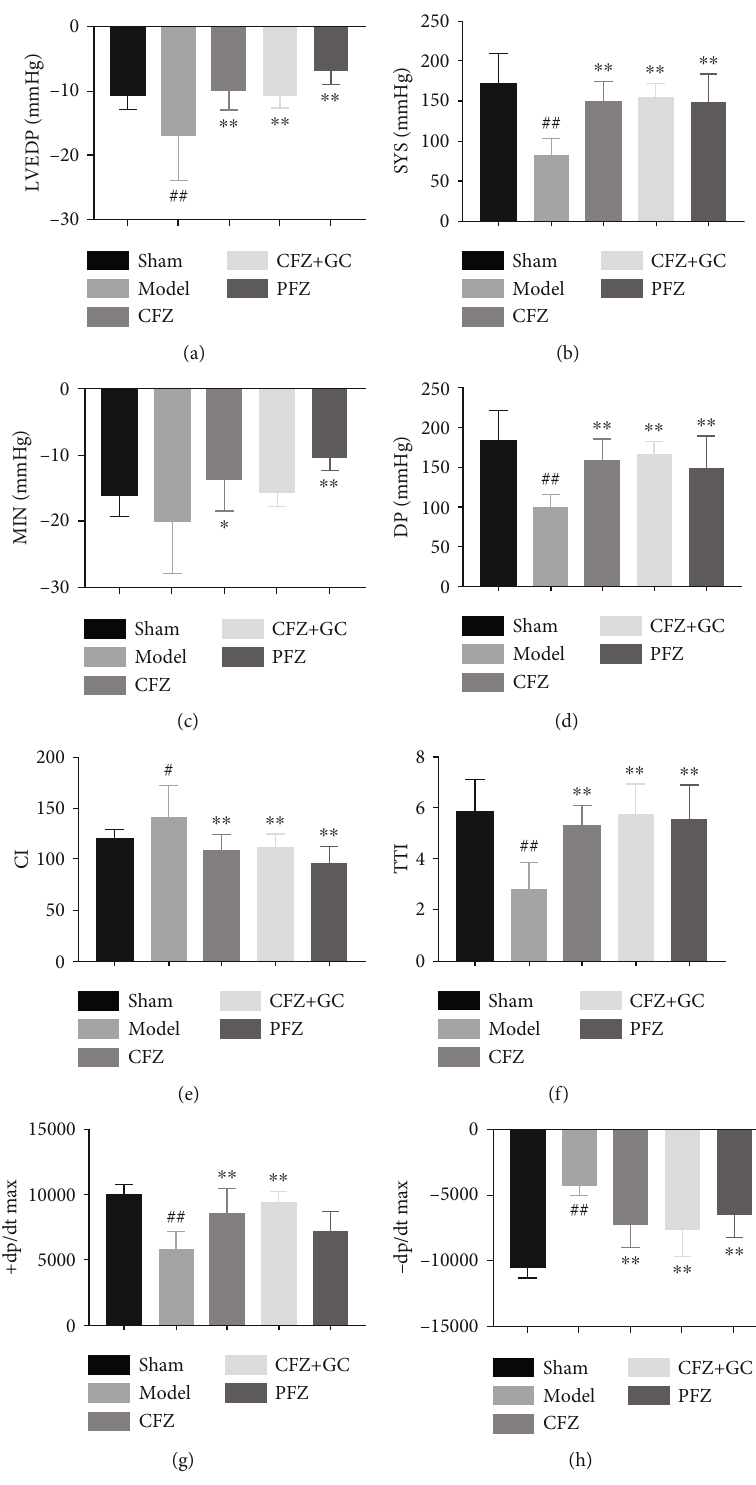
Figure 3: Ventricular pressure indicators in mice of each group: (a) LVEDP: left ventricular end-diastolic pressure; (b) SYS: systolic pressure; (c) MIN: minimum intracardiac pressure; (d) DP: diastolic pressure; (e) CI: cardiac index; (f) TTI: tension time index; (g) +dp/dt max: maximum rate of increase of left ventricular pressure; (h) − dp/dt max: maximum rate of left ventricular pressure decline. Sham group ( n = 7 ), model group ( n = 7 ), crude Fuzi (CFZ) group ( n = 5 ), CFZ combined with Glycyrrhiza (CFZ+GC) group ( n = 9 ), and prepared materials of Fuzi (PFZ) group ( n = 9 ). All data are presented as the mean ± SD . # P < 0 : 05 and ## P < 0 : 01 versus the sham group; ∗ P < 0 : 05 and ∗∗ P < 0 : 01 versus the model